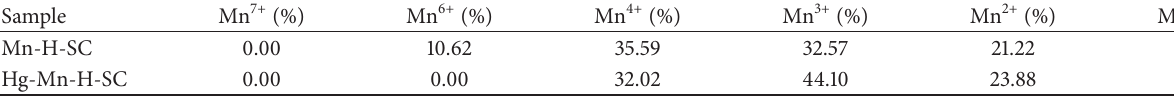
Table 3: Distribution of surface Mn ions of Mn-H-SC, and Hg-Mn-H-SC.